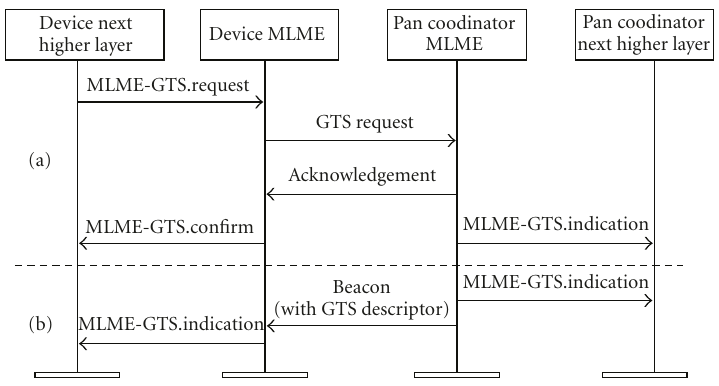
Figure 19: Sequence diagram for a GTS deallocation request by a device node (a); explicit removal by the coordinator (b).